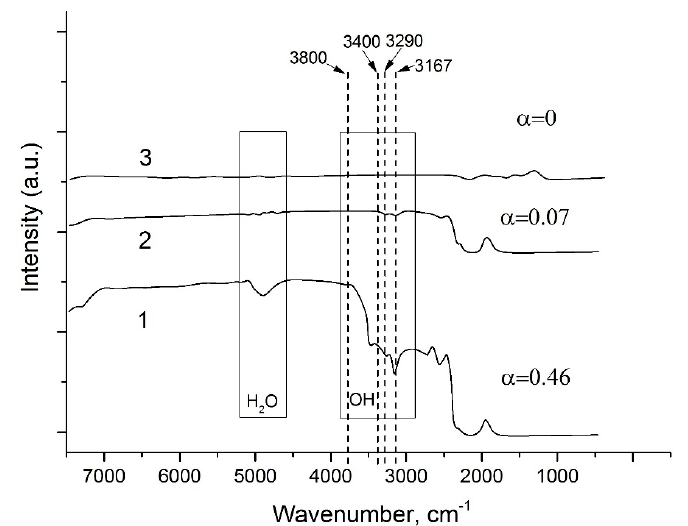
Figure 9. IR spectra of GaPO 4 crystals obtained under follow conditions: 1—hydrothermal solution, 9 M H 3 PO 4 / 12 M HCl (80 / 20), T = 240 ◦ C, dT = 10 ◦ C, refluxing method, isometric crystals; 2—hydrothermal solution, 6 M H 2 SO 4 , T = 230 ◦ C, dT = 4 ◦ C, temperature gradient method, plate-like crystals, 3—flux,